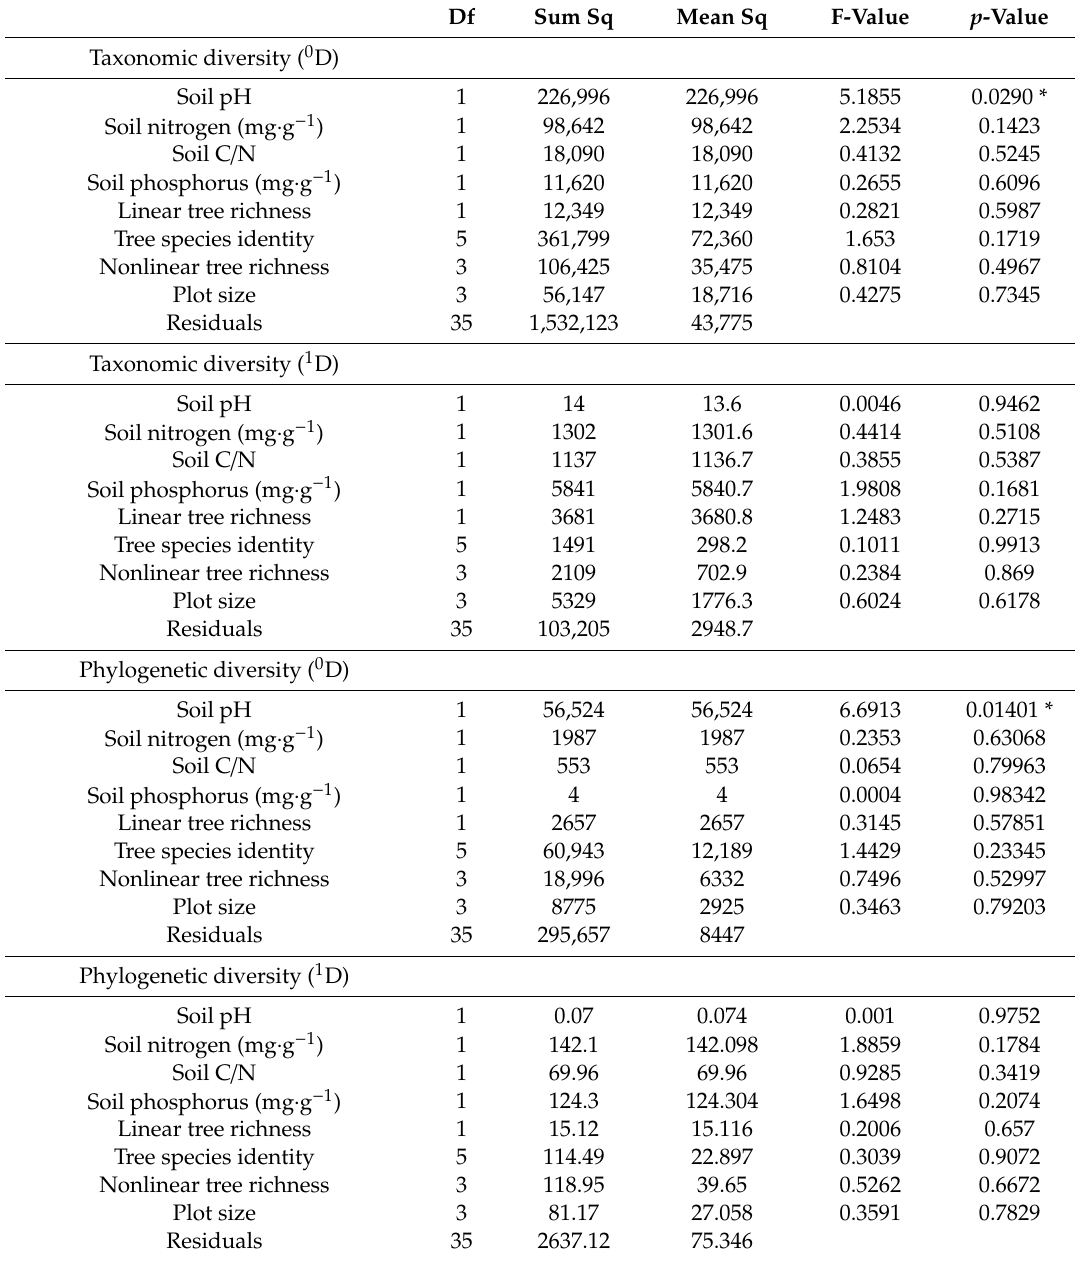
Table 2. Effect of soil variables and tree enrichment on fungal diversity in the oil palm plantation. Hill numbers were calculated with weight on OTU abundance equal to zero ( 0 D) and one ( 1 D). Significanteffects were testedusing ANOVA.Df: degrees offreedom, Sq: square, C / N:carbon-to-nitrogen ratio, * p < 0.05. Nonlinear tree richness is an approximation for interactions among tree species, independent of their